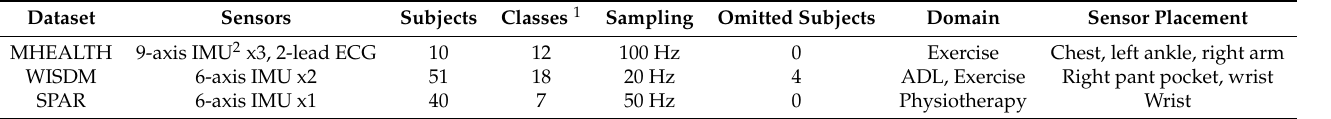
Table 1. Experimental inertial datasets.